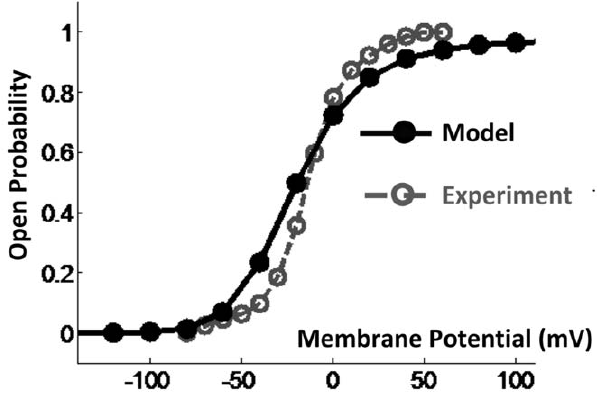
Figure 6. Steady state activation curve computed at several membrane potentials. Solid line shows the simulation results; dashed line is from experimentally measured currents.